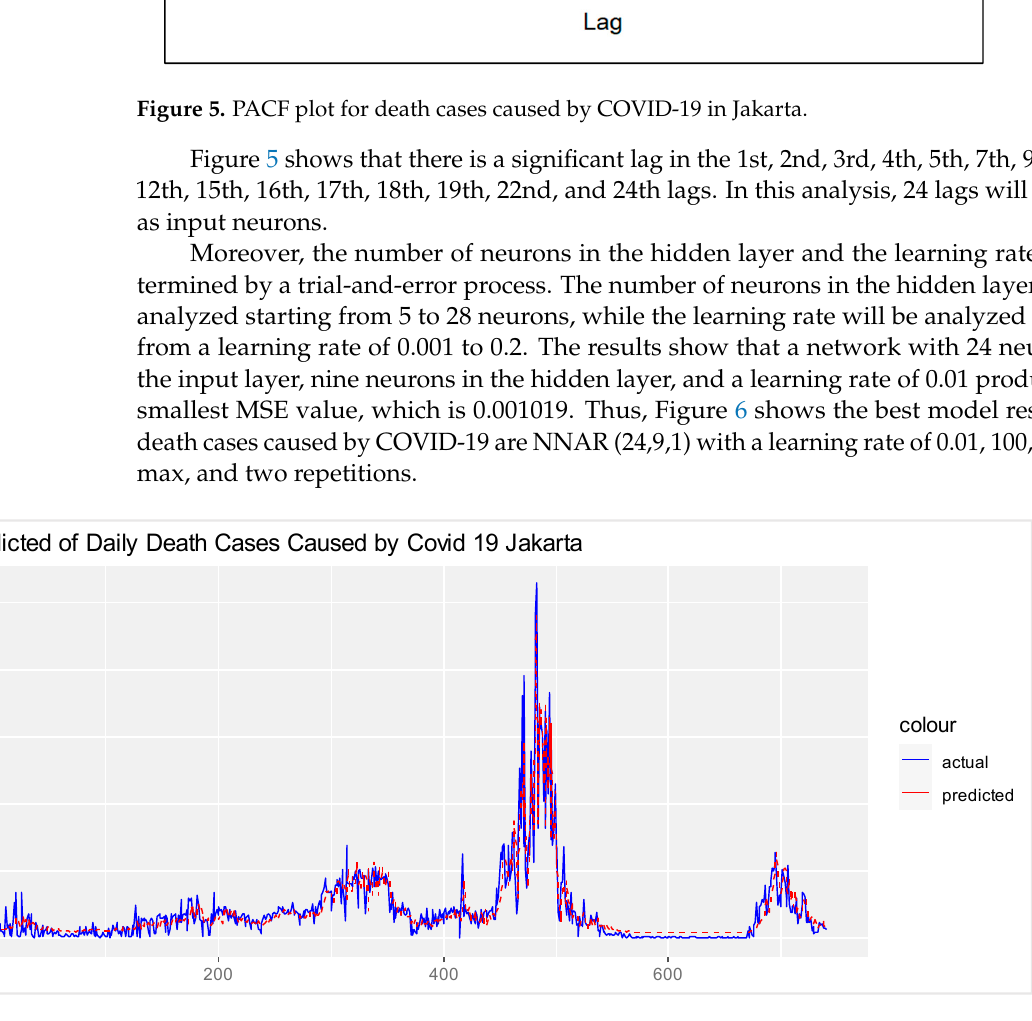
Figure 6. A plot of actual data and predicted data on death cases due to COVID-19 in Jakarta.